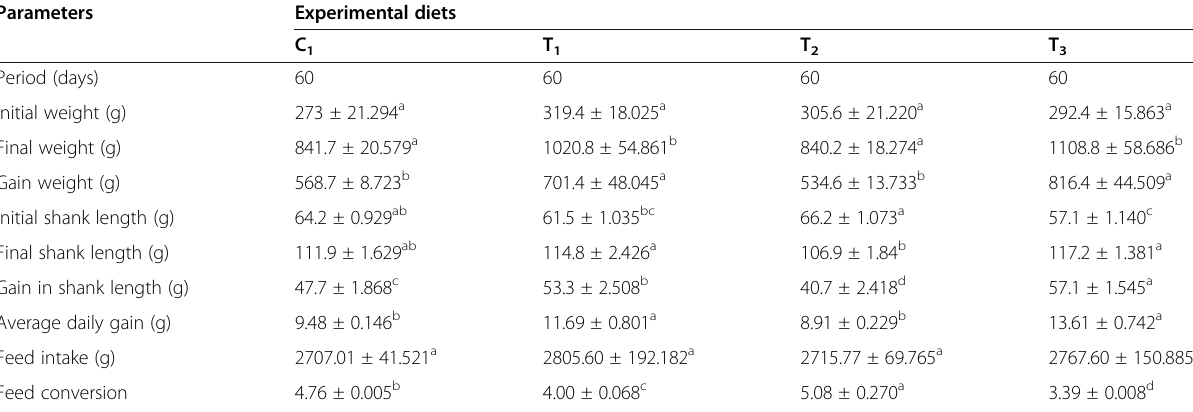
Table 3 Effect of seaweed ( Ulva lactuca ) and Azolla feed supplement on growth, shank length, feed intake, average daily gain and feed conversion (mean ± SE)